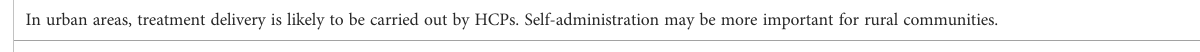
TABLE 1 Recommendations on the self-administration of SC DARA. A reliable and user-friendly administration device would be required to facilitate the successful self-administration of SC DARA. This would ideally be pre-loaded, so that the patient does not need to prepare anything. Some hospital trusts do not, at present, have the capacity to enable changes in treatment delivery and should be supported to allow innovative ways of delivering chemotherapy in patients ’ homes. This would include patient education support, safe delivery and disposal of medication, and appropriate reimbursement. In urban areas, treatment delivery is likely to be carried out by HCPs. Self-administration may be more important for rural communities. Some patients may not want to administer an injection, therefore self-administration could increase the stress of treatment. Many patients prefer an HCP to administer their treatments. Patients should be supported if this is their choice. DARA, daratumumab; HCP, healthcare provider; SC,